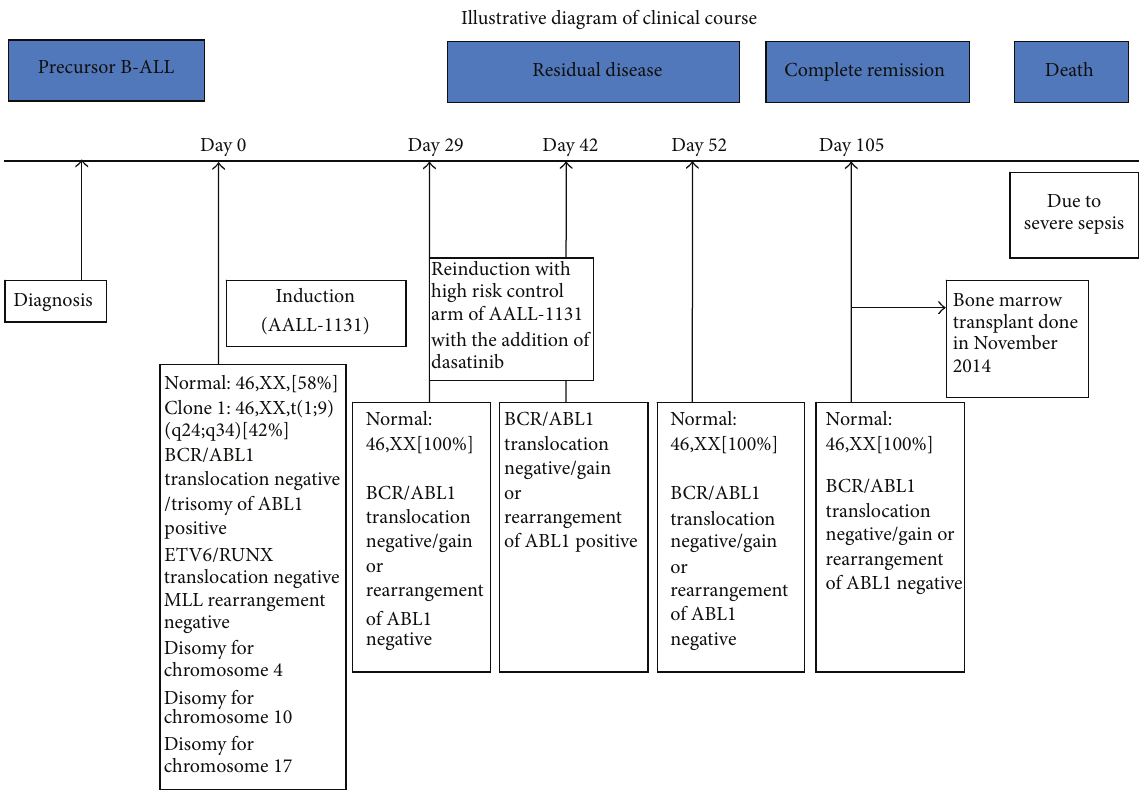
Figure 1: Illustrative diagram showing clinical course of the patient.